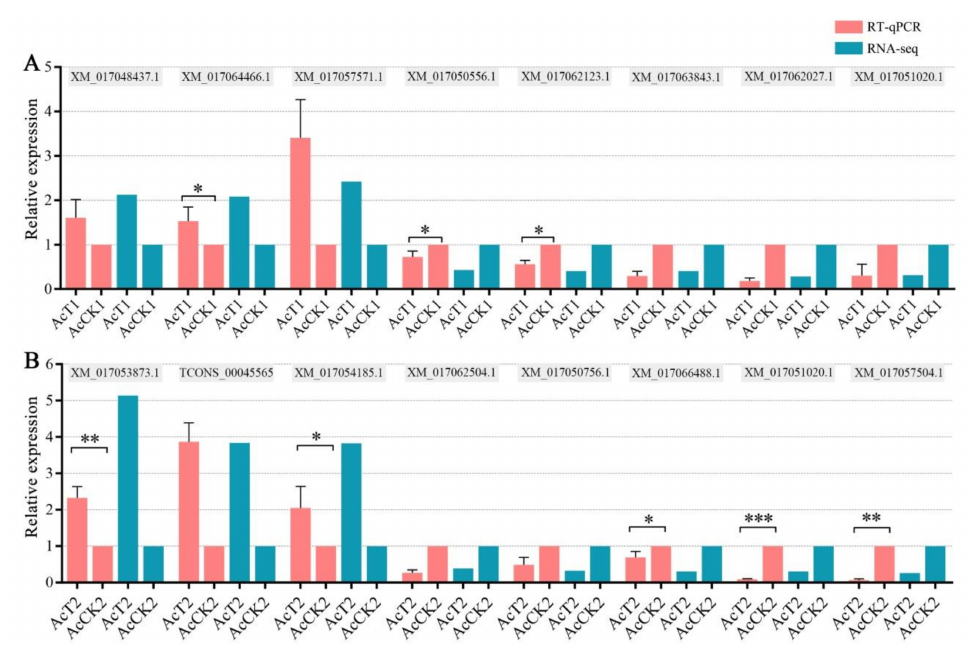
Figure 3. RT-qPCR validation of DEGs in AcCK1 vs. AcT1 ( A ) and AcCK2 vs. AcT2 ( B ) comparison group. * p < 0.05; ** p < 0.01, *** p <